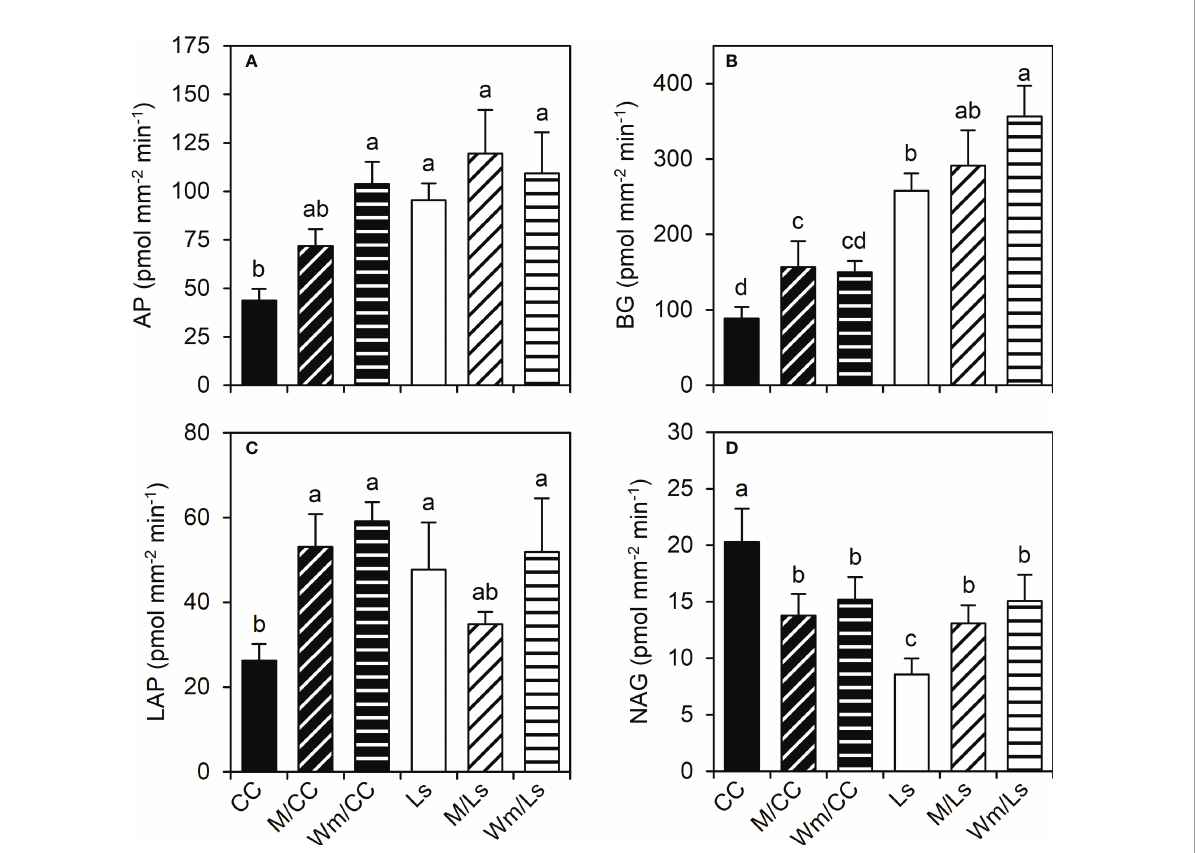
FIGURE 4 Potential enzyme activities (pEA root , pmol mm − 2 min − 1 ) of (A) acid phosphatase (AP), (B) b -glucosidase (BG), (C) leucine-amino-peptidase (LAP), and (D) N-acetyl-glucosaminidase (NAG) at root tips of different graft combinations of self-grafted Cucurbita maxima × Cucurbita moschata (CC) and Lagenaria siceraria (Ls), and of respective heterografts with melon (M) and watermelon (Wm) at day 60 after grafting (DAG 60). Different letters indicate signi fi cant differences per enzyme (Tukey test, p < 0.05; mean ± SE). See Supplementary Table S2 for details including two-way ANOVA results, and Supplementary Table S3 for pEA root of basal root